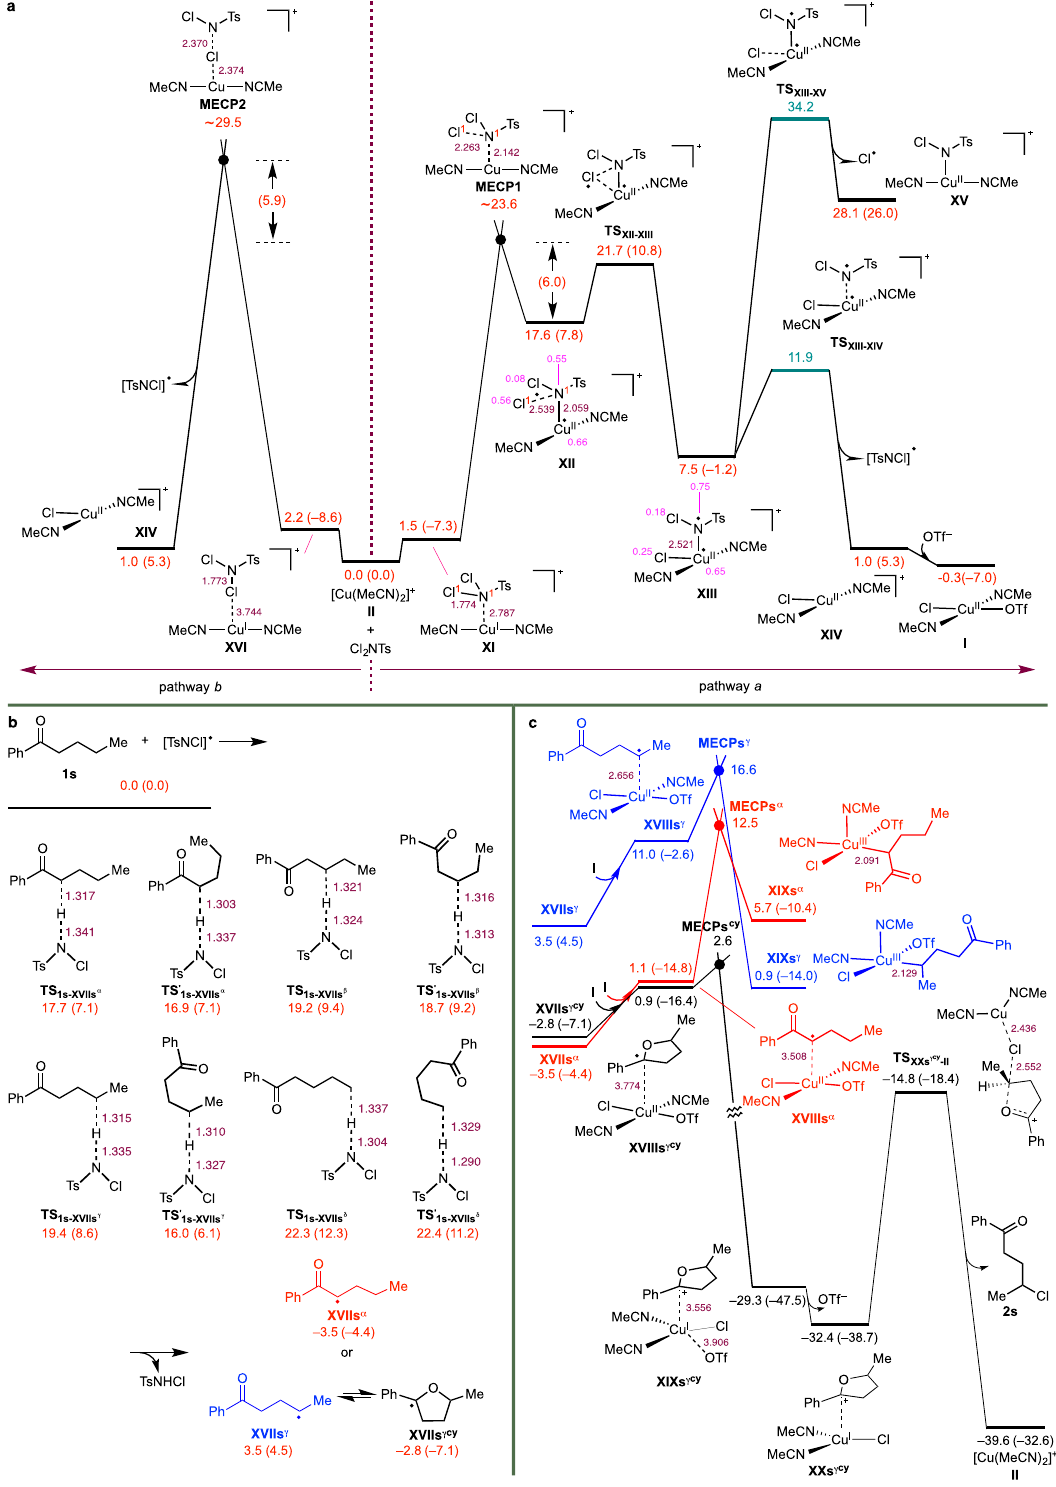
Fig. 4 DFT calculations. a Energy pro fi les for the oxidative addition of dichloramine-T to [Cu(CH 3 CN) 2 ] + II via the SET mechanistic pathways a and b . b Energy barriers for the HAT reaction of [TsNCl] • at different positions of 1s and relative energies of the ensuing radical species XVIIs α , and XVIIs γ and XVIIs γ cy produced from the two most favoured transition states, TS ′ 1s-XVIIs α and TS ′ 1s-XVIIs γ . c Energy pro fi le for the chlorination of XVIIs α , XVIIs γ and XVIIs γ cy to 2s . The relative Gibbs free and potential energies (in parentheses) obtained from SMD/B3LYP-D3/def2-TZVP//SMD/B3LYP-D3/6-31G( d , p ), SDD calculations are given in kcal/mol (red), bond lengths in A ̊ (purple) and spin density distribution values in e/Å 3 (pink).